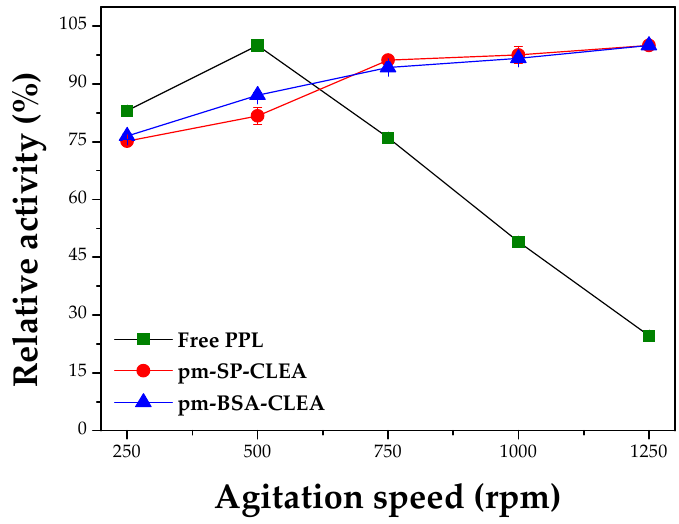
Figure 8. Effect of the agitation on the catalytic performance of free and immobilized PPL. Conditions of pm-(BSA or SP)-CLEA preparation: treatment of PPL surface with dodecyl aldehyde (PPL/dodecyl aldehyde mass ratio of 1:1), aggregation/precipitation with ethanol (enzyme solution/ethanol volume ratio of 1:3) in presence of PPL/BSA/SMNPs or PPL/SP/SMNPs mass ratio of 1:1.5:1.5 and starch (0.8% w / v ) for 0.5 h, followed by treatments with glutaraldehyde (5 μ moles of glutaraldehyde/mg total protein) for 15 h at 4 °C under 150 rpm stirring, and with α -amylase at 25 °C under 150 rpm stirring for 2 h. Activity assay conditions: hydrolysis of tributyrin solution (217.9 mM concentration) at 40 °C and pH 8.0 for 5 min under different agitation velocities (250, 500, 750, 1000 and 1250 rpm).